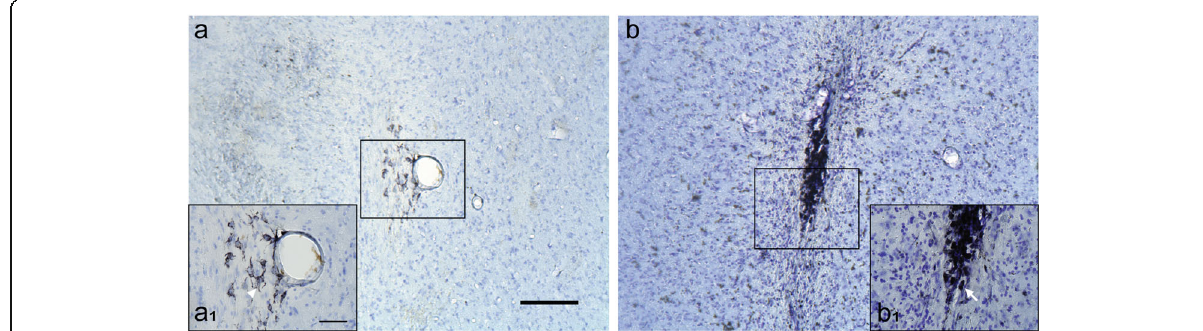
Fig. 1 Brain tissue sections of the putamen immunostained against CD68 and counterstained with Nissl showing examples of resting/ramified